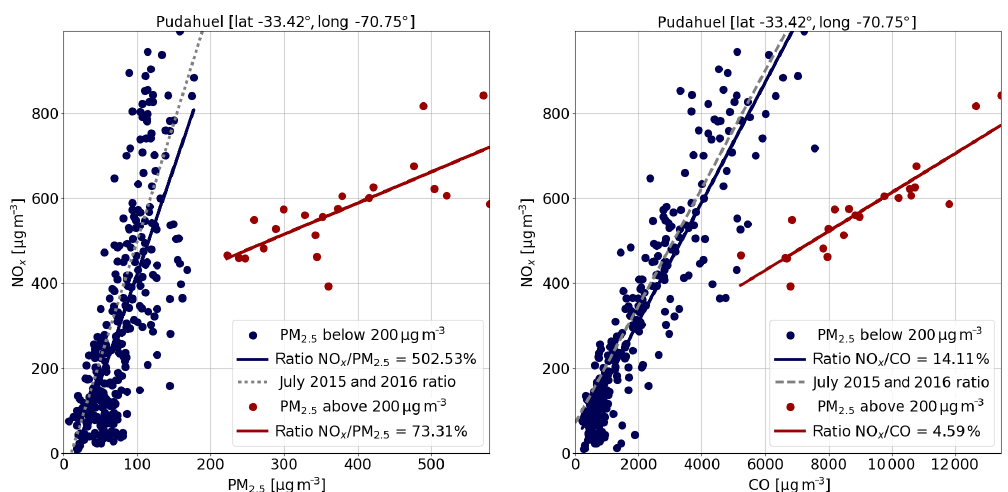
Figure 7. Observed NO x / CO and NO x / PM 2 . 5 concentration ratios at Pudahuel station (PDH). Blue dots are for PM 2 . 5 concentrations below 200µgm − 3 ; red dots are for PM 2 . 5 concentrations above 200µgm − 3 ; gray line represents the ratio for July 2015 and 2016; blue and red lines correspond to linear regressions for each